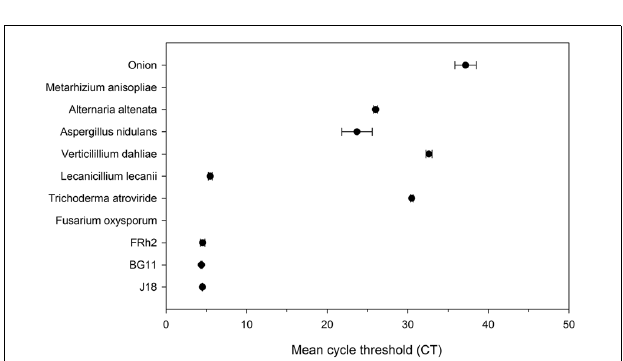
FIGURE 3 | Real time qPCR amplification of multiple fungal species and plant host DNA (onion and maize), versus Beauveria bassiana isolates (BG11, FRh2, J18) ( Y axis) over mean cycle threshold (CT) values ( X axis) with standard deviation error bars (where possible). Amplification was performed using EF4F and EF4R as nested step 2 PCR on product generated from primers EF3F and